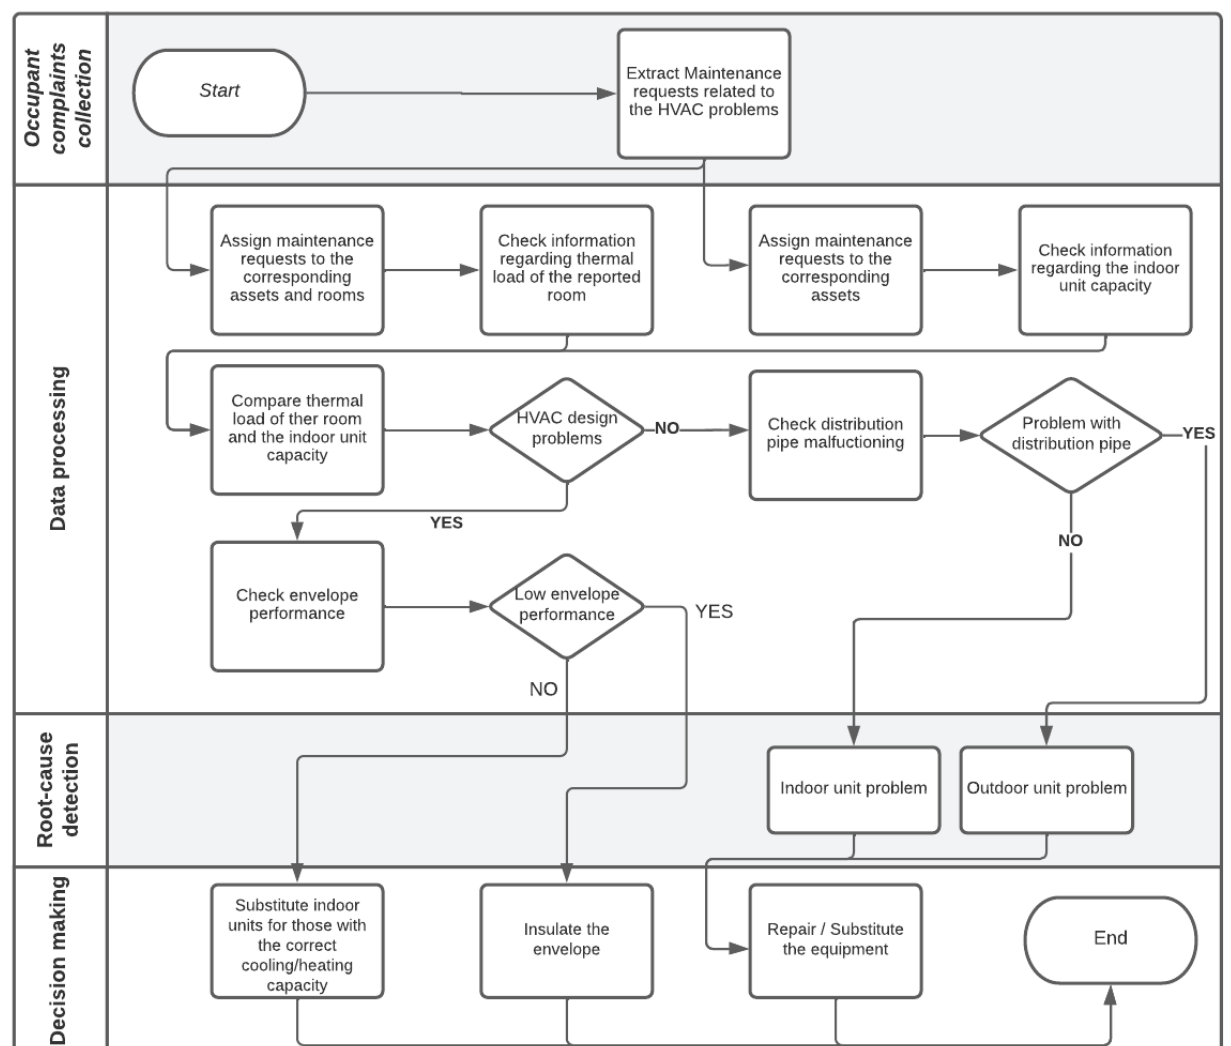
Figure 1. Conceptual model and decision-making framework for HVAC root-cause detection.